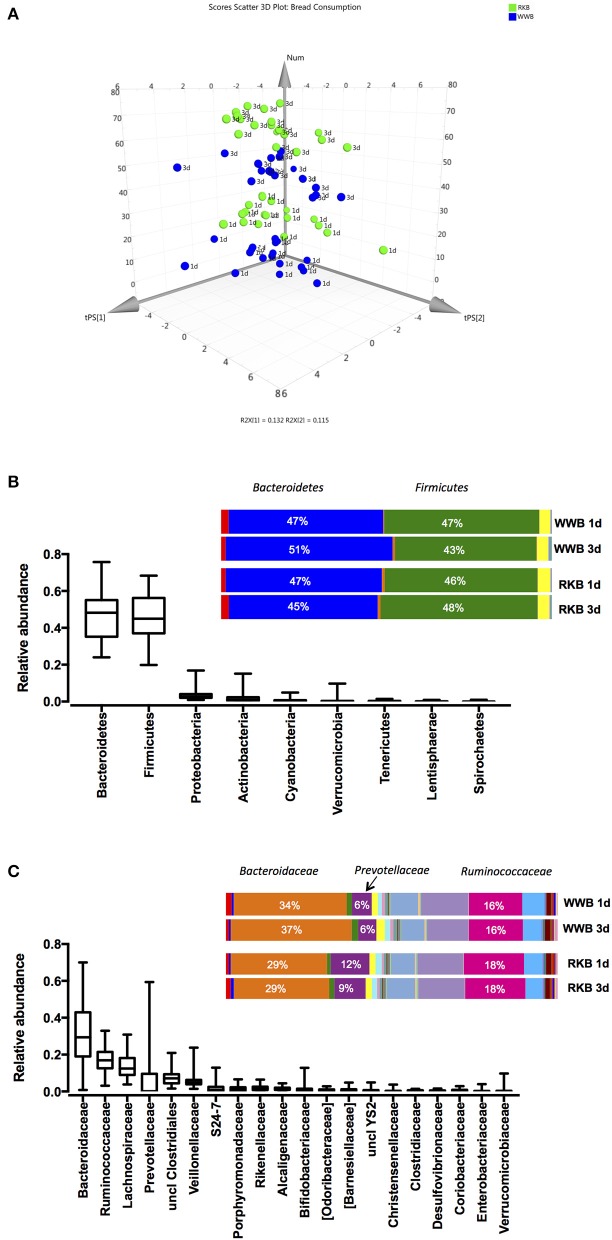
3D PCA plot of data points for each participant after WWB and RKB product consumption during 1 or 3 d period (A); Relative abundance of OTUs taxonomically assigned to bacterial phyla (B) and family (C) level, of all participants at all visits (unfilled boxplots, n = 74) or per test occasion (colored bars), where RKB 1d (n = 18), WWB 1d (n = 18), RKB 3d (n = 19), WWB 3d (n = 19) WWB, white wheat bread; RKB, rye kernel bread.